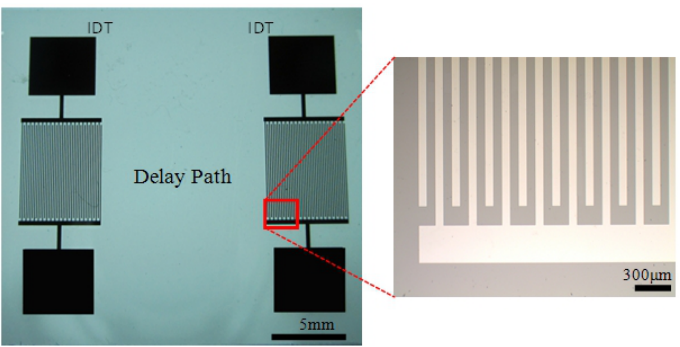
Figure 3. Fabricated ST-cut Quartz